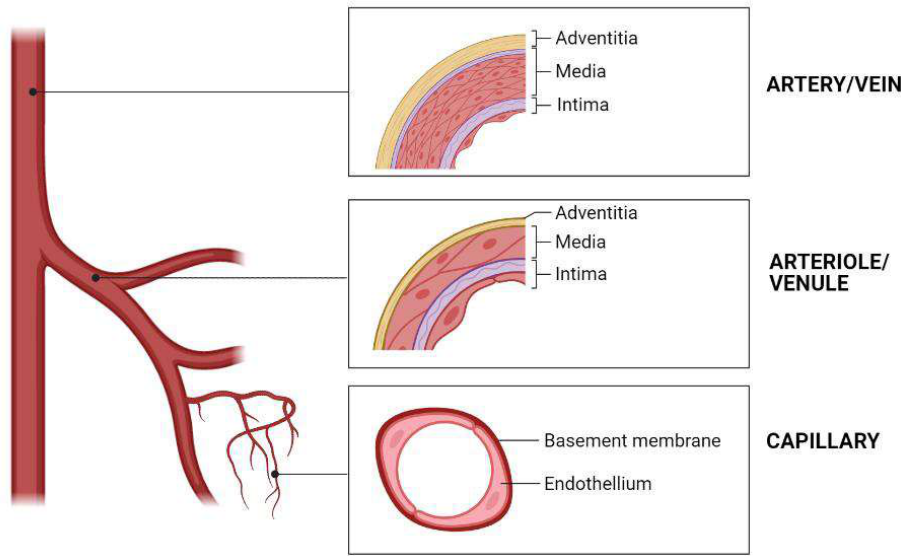
Figure 1. Hierarchical vascular tree and cross sections of different blood vessels, showing different blood vessel structures.